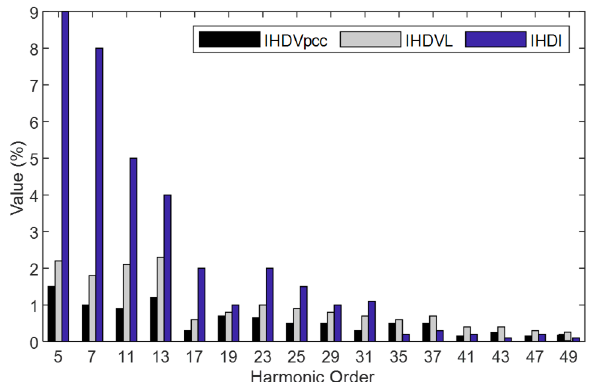
were done for scenario 1 and based on the AOA method. The obtained results are repre- sented in Table 6. Figure 8. The individual harmonic voltage and current distortion values—scenario 1. To show the POF performance, the CTF parameters which have been optimized in this paper were compared with the results obtained from the OF in [29]. Both simulations